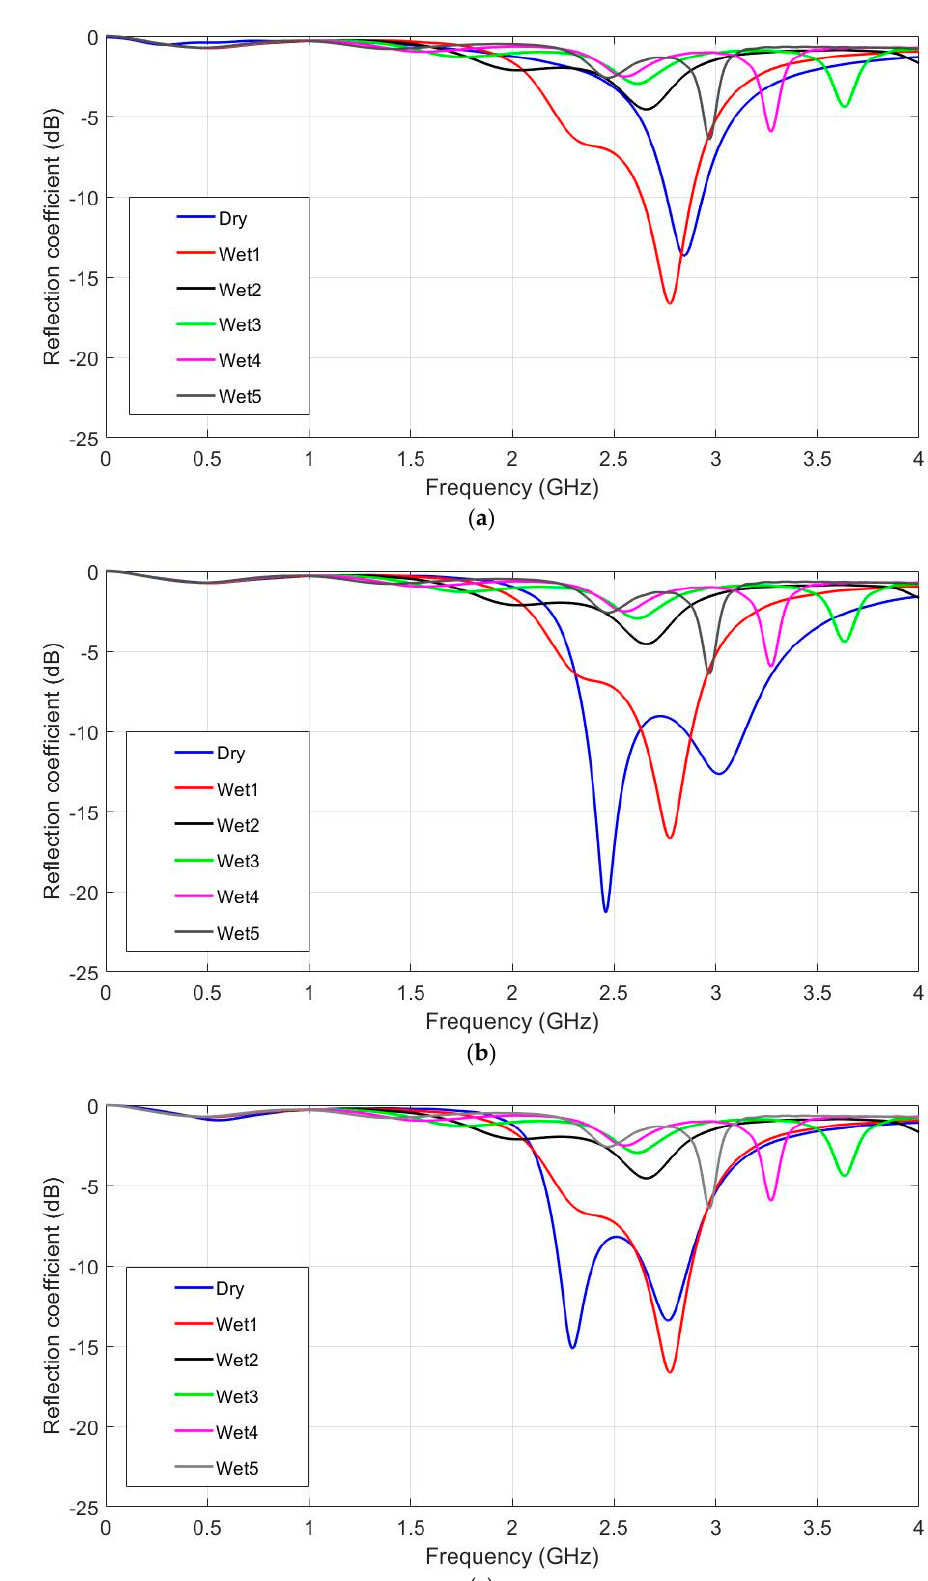
Figure 8. Simulated reflection coefficient for the different water concentration values. ε r = 1.3 and tan δ = 0.058. ( a ) hs = 2 mm, ( b ) hs = 6 mm and ( c ) hs = 10 mm.